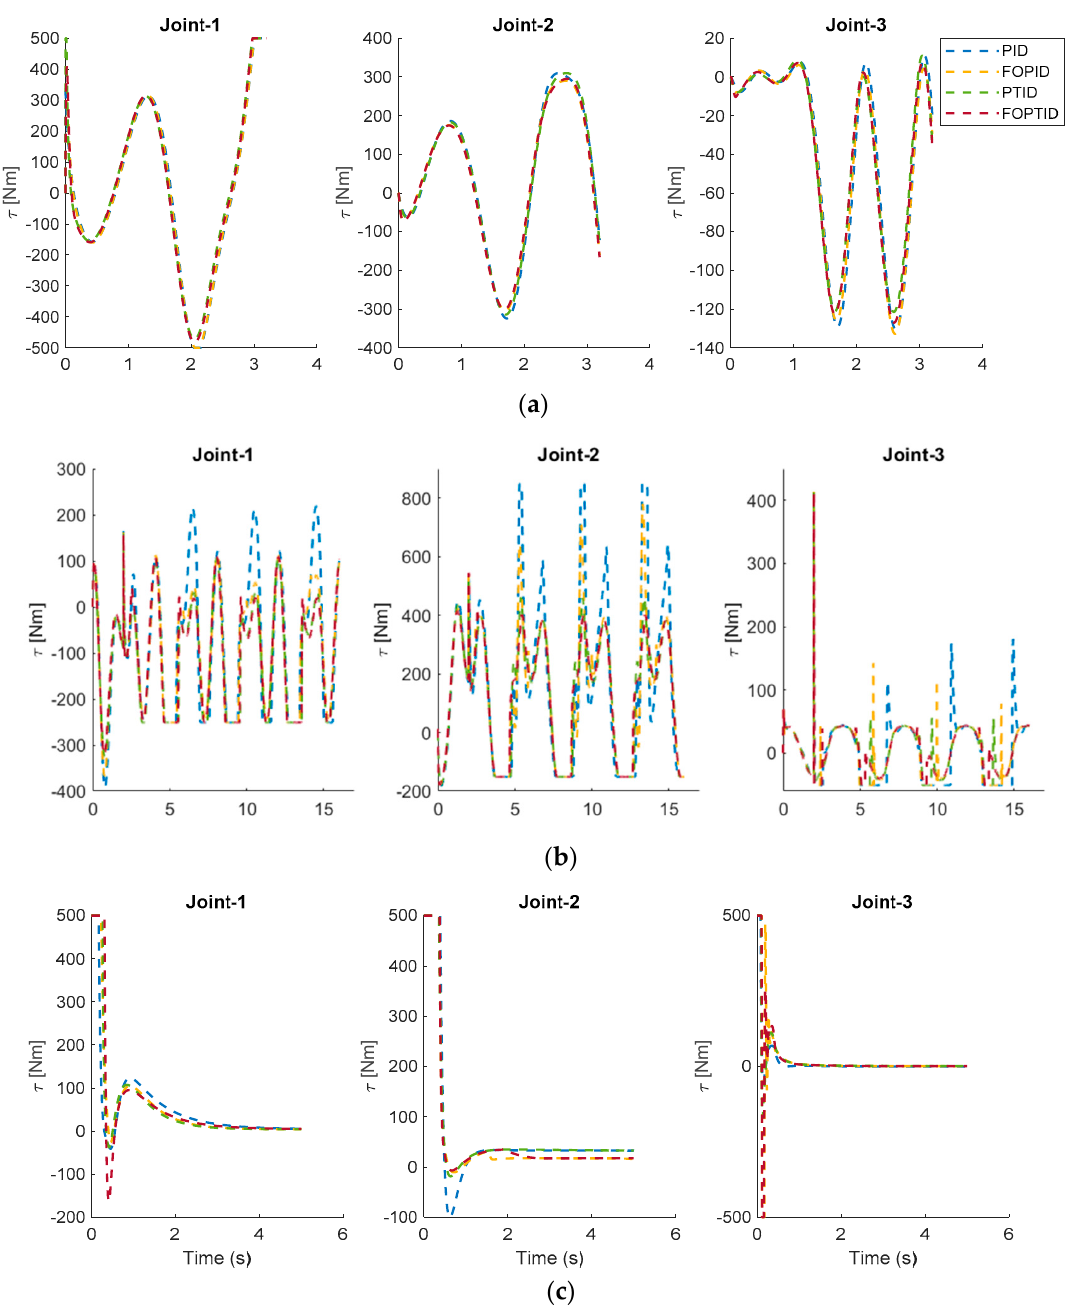
Figure 17. Simulation results of the tuned controllers for the torques of each joint based on the different trajectory ( a ), disturbance rejection ( b ) and friction compensation ( c ) tests.